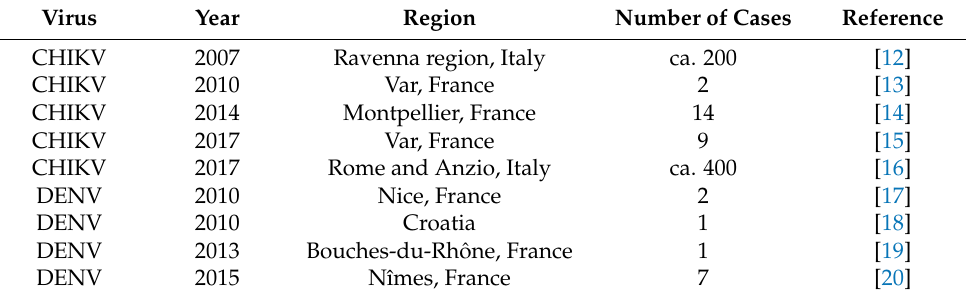
Table 1. European cases of Aedes albopictus -associated virus transmission. CHIKV: chikungunya virus; DENV: dengue virus.